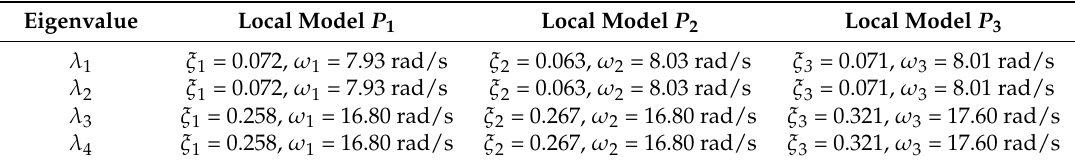
Table 3. Relative Damping and Natural Frequencies for Eigenvalues of the Identified Local Models.